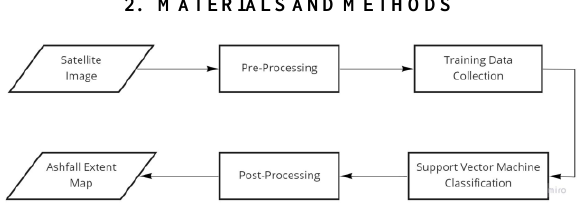
Figure 1. Potential ash extent map general